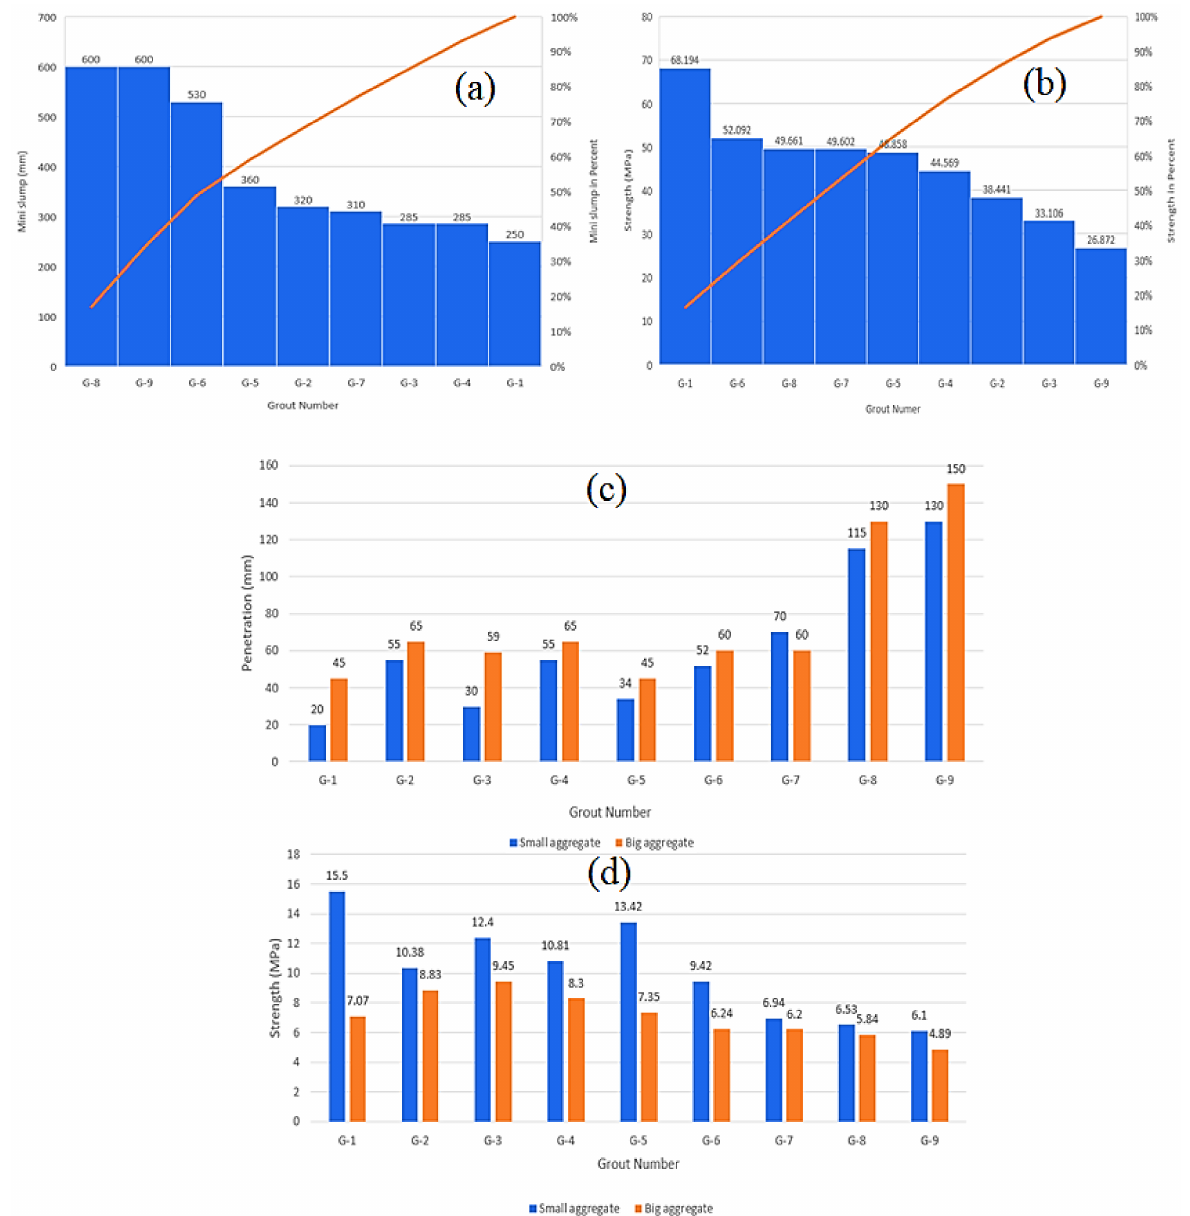
Figure 13. ( a ) Mini slump spread and ( b ) compressive strengths (MPa) of nine different grouts. ( c ) Mass permeability, water penetration depths, and ( d ) mass strengths of grout samples with fine and coarse